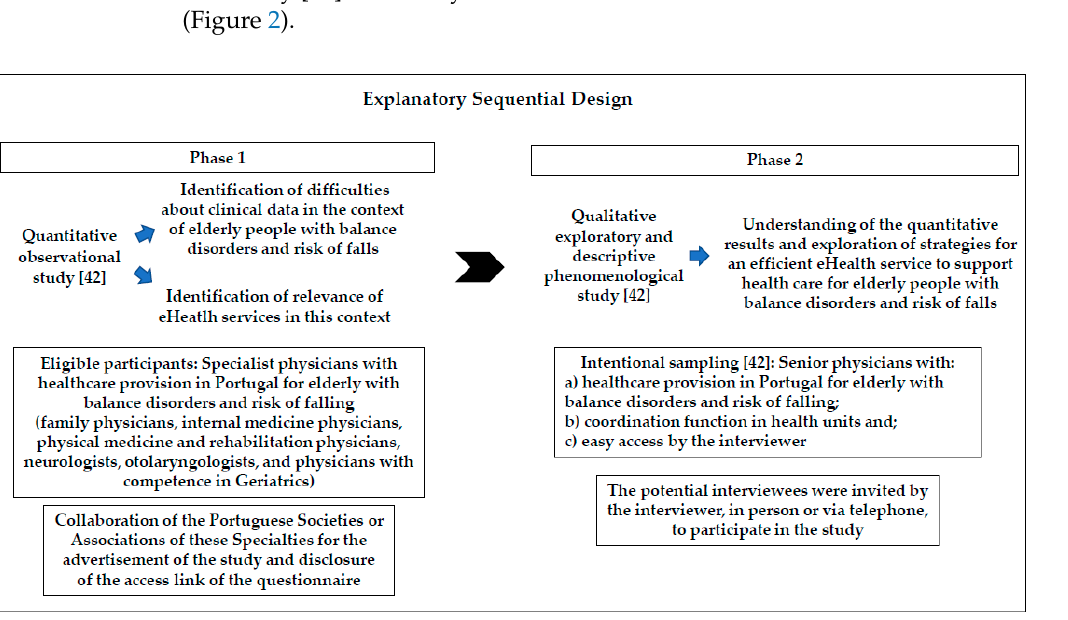
Figure 2. Design of the mixed methods study